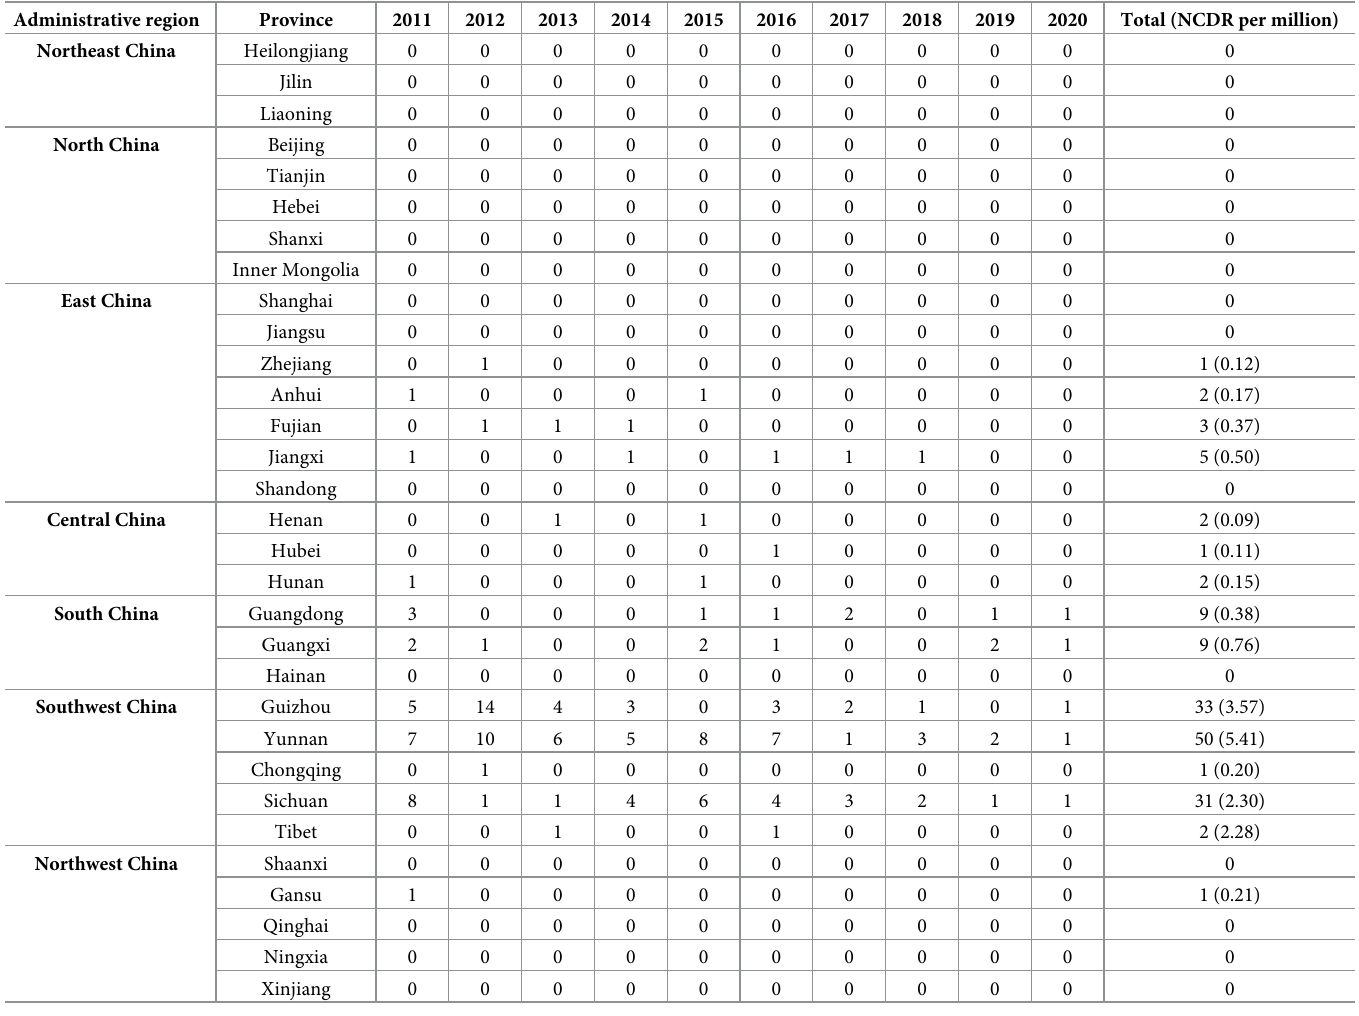
Table 1. Spatial distribution of pediatric leprosy cases in China, 2011–2020. Administrative